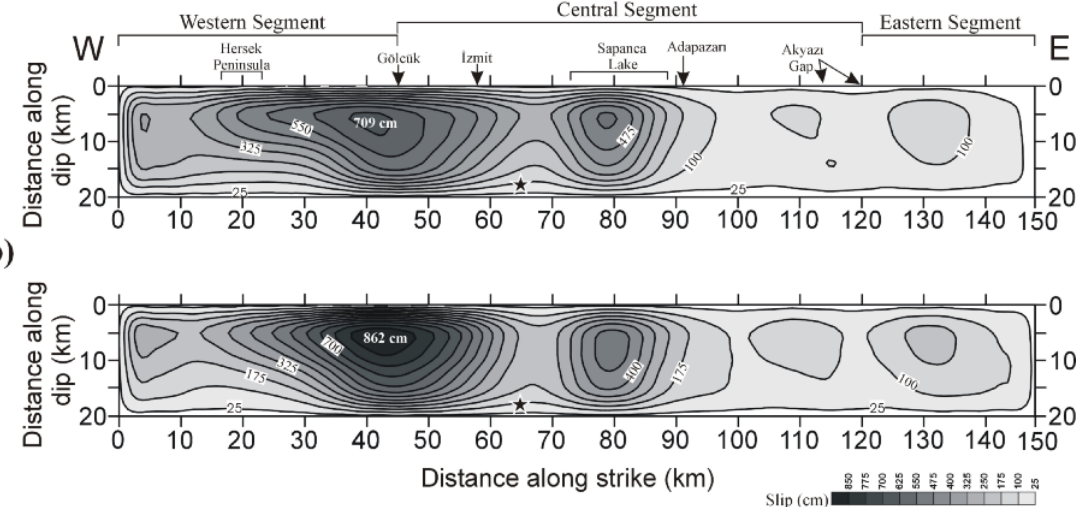
! Figure 6. a) Contour map of the slip distribution that gives the best fit to the teleseismic velocity data and is assumed as the coseismic slip distribution model (model M1 in Table 3) of the 1999 İ zmit earthquake in the present study. The central segment has a rupture velocity of 3.5 km/s while the other segments have a rupture velocity of 3.3 km/s. b) Contour map of the coseismic slip distribution of the 1999 İ zmit earthquake arising from the present study, with the central segment of the model fault plane having a rupture velocity of 5 km/s, and the other segments having a rupture velocity of 3.3 km/s. This model corresponds to model M10 in Table 3. Note that slip larger than 25 cm is contoured at 75-cm intervals. Solid star, hypocenter. The projected